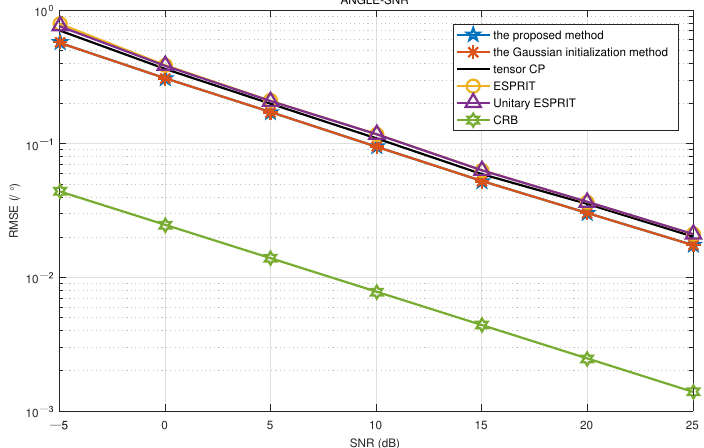
Figure 3. RMSE of angle estimation versus SNR.